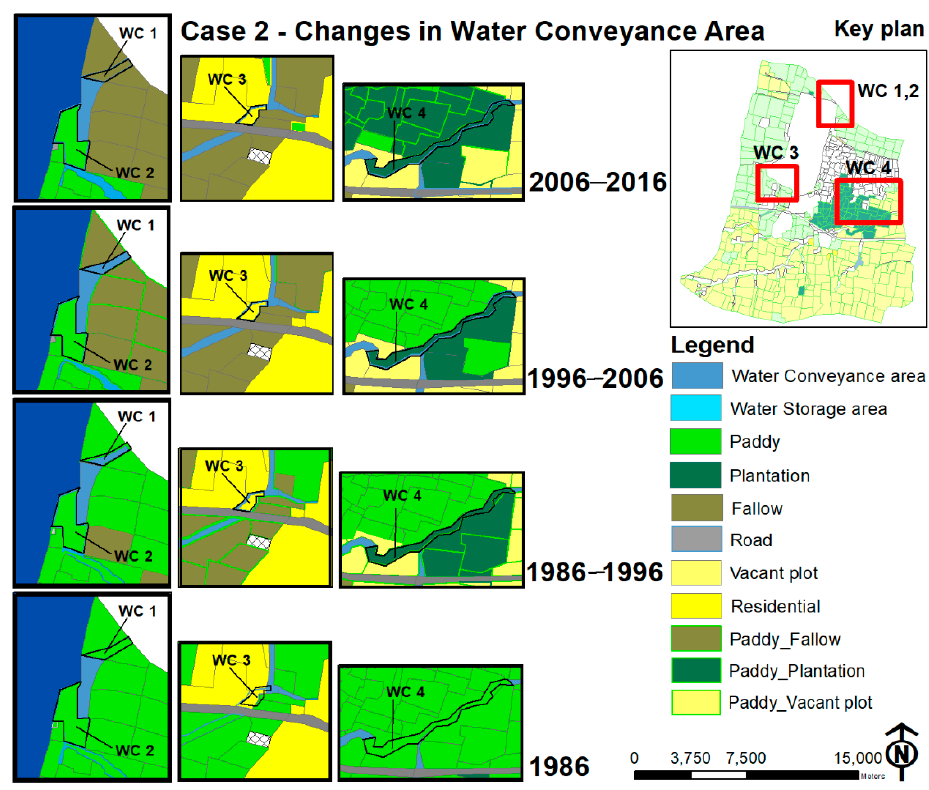
Figure 10. Trajectories of change: Case 2—water conveyance area.